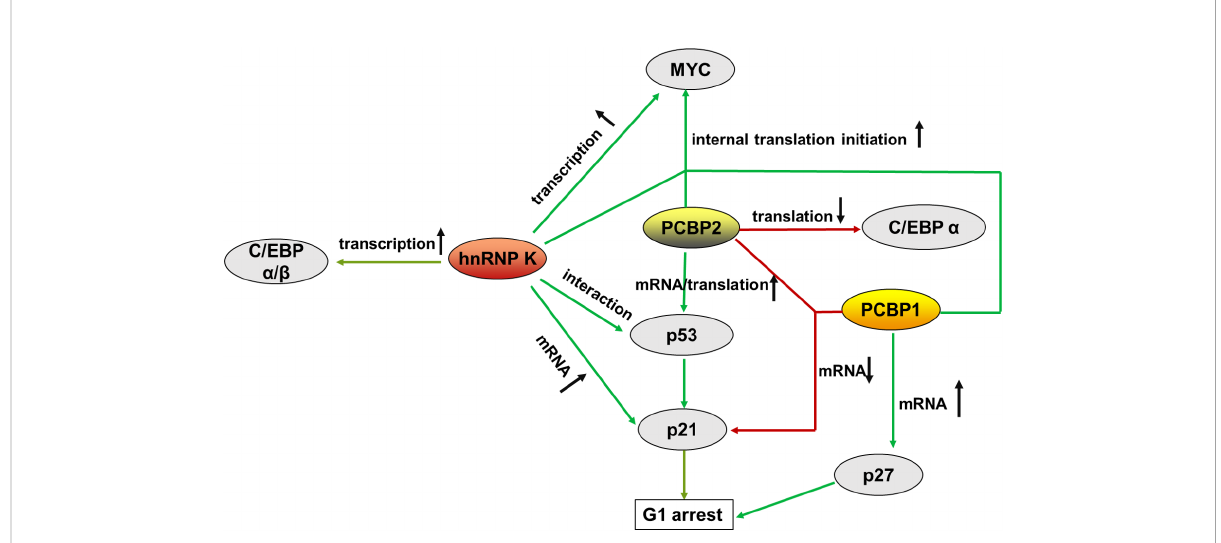
FIGURE 3 Summary of the main molecules of PCBPs that regulate hematopoietic malignancy, from transcriptional to translational control. represents augment, represents a